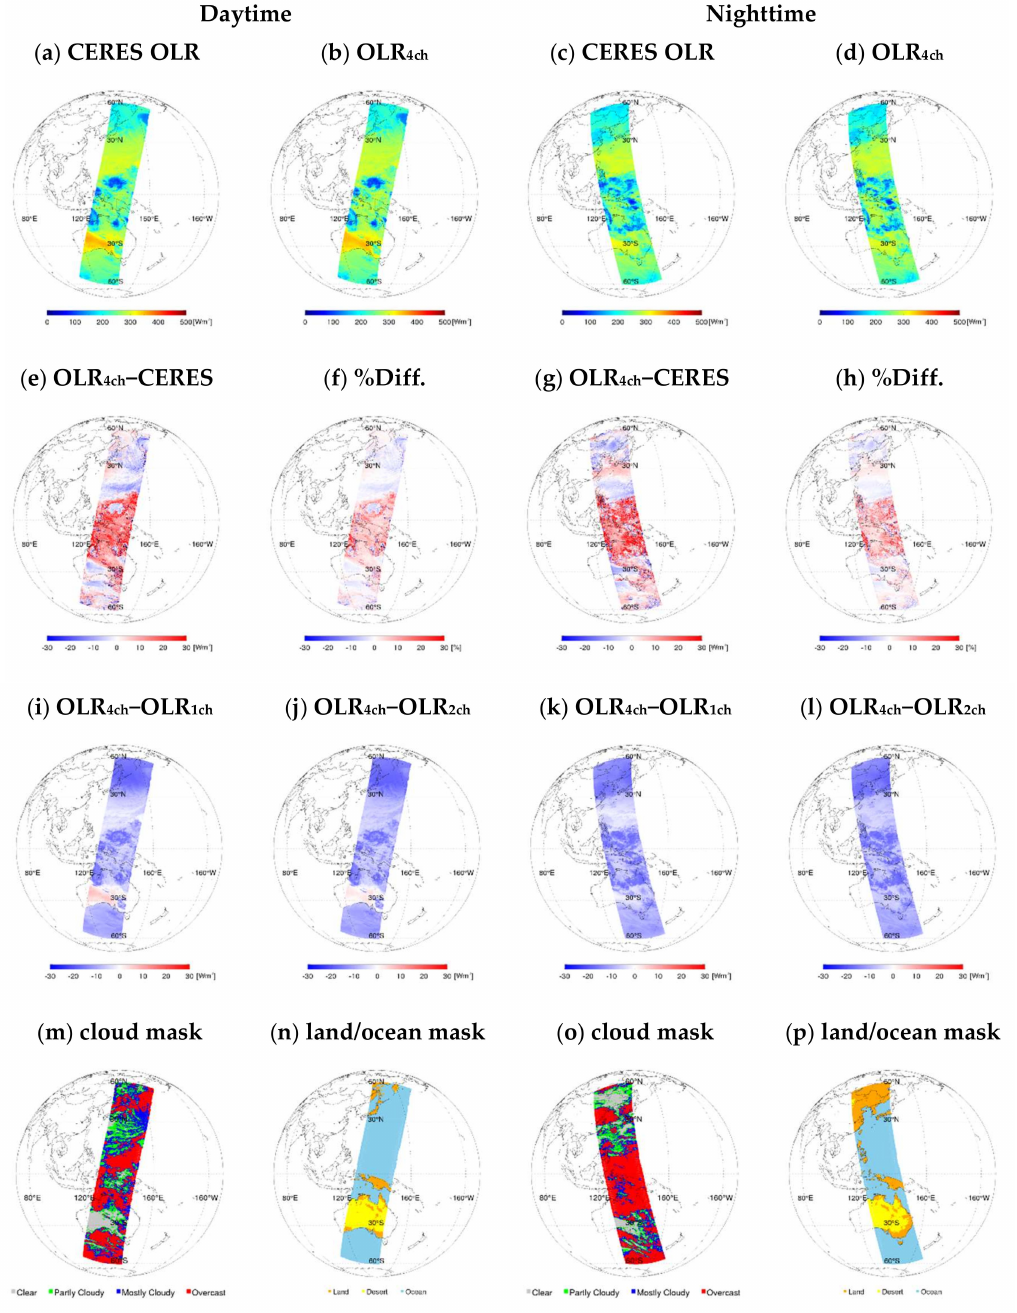
Figure 5. CERES OLR and OLR 4ch for the daytime (left)/nighttime (right) case of January 4, 2017 ( a , b , c , d ), the difference between these two OLR values ( e , f , g , h ), and the distribution of the differences among OLR 1ch , OLR 2ch , and OLR 4ch ( i , j , k , l ). The cloud mask and land/ocean mask for each case are shown in figure ( m , n , o , p ). “%Diff.” is (OLR 4ch − CERES)/CERES ×